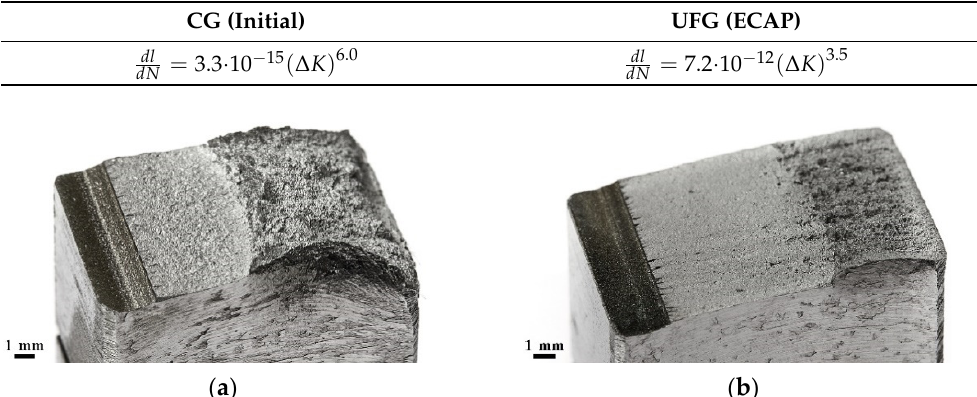
Figure 7. Straight-line portion of the kinetic diagrams of fatigue fracture for the steel in the initial state (bright dots) and after ECAP (dark dots). Table 6. Paris equations describing the straight-line portion of the kinetic diagrams of fatigue fracture for the steel after different types of treatment.